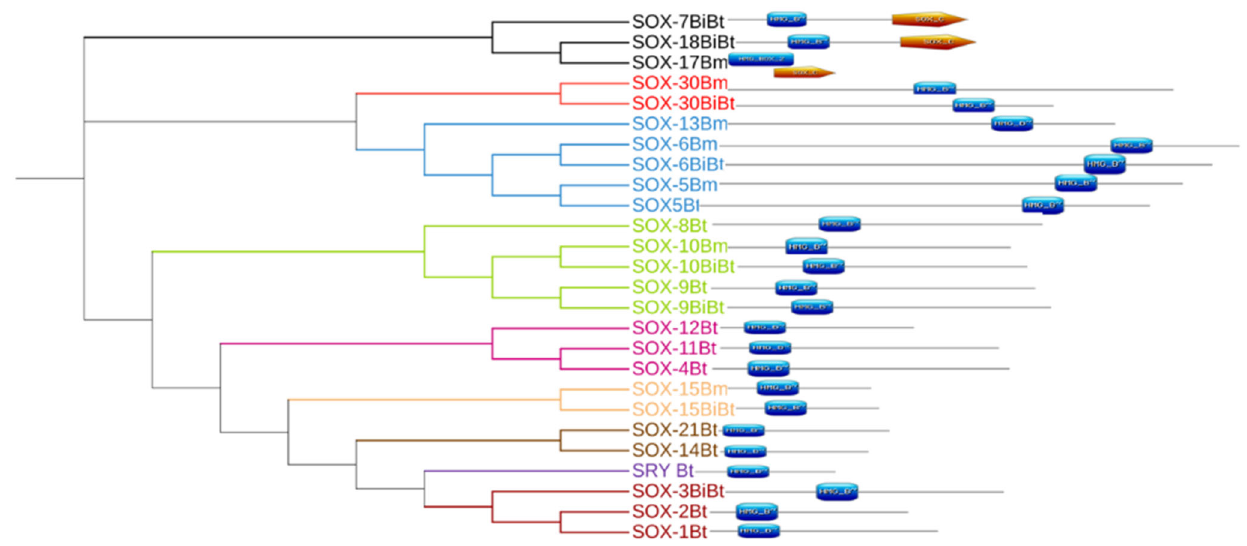
Figure 7. Comparison of intra-domain features of Sox proteins. This comparison shows the HMG box and Sox C domain that provide additional information about the structure and functions of Sox proteins. Members of Sox F subfamily have an additional C- terminal domain.